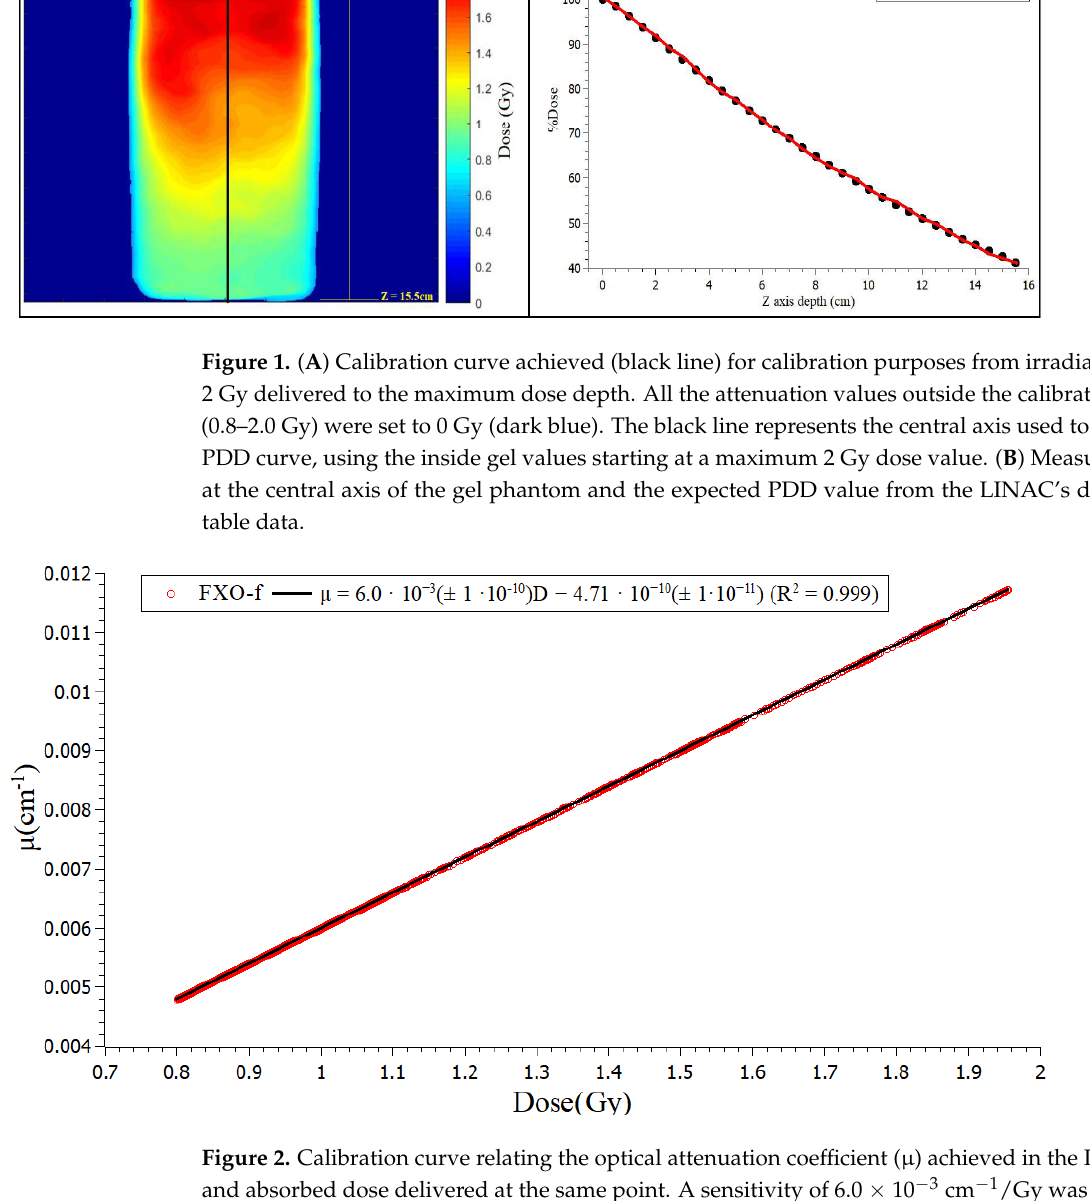
Figure 1. ( A ) Calibration curve achieved (black line) for calibration purposes from irradiation with 2 Gy delivered to the maximum dose depth. All the attenuation values outside the calibration range (0.8–2.0 Gy) were set to 0 Gy (dark blue). The black line represents the central axis used to build the PDD curve, using the inside gel values starting at a maximum 2 Gy dose value. ( B ) Measured PDD at the central axis of the gel phantom and the expected PDD value from the LINAC’s dosimetric table data.